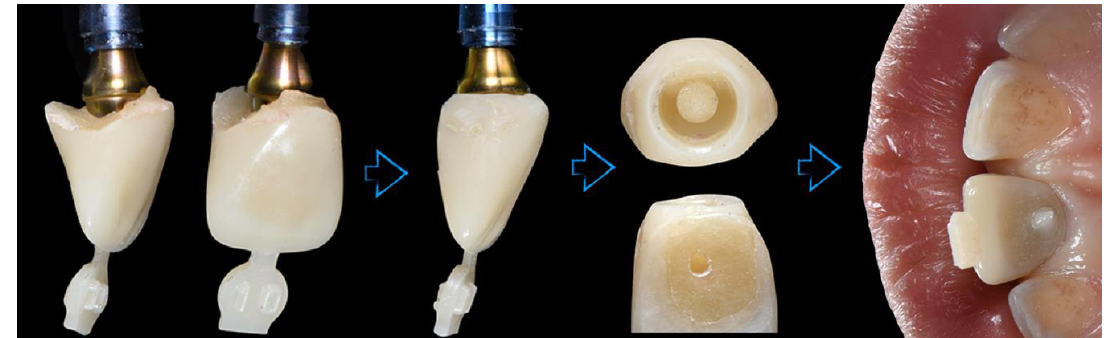
Figure 15. Fabrication and relining of the second provisional (transitional) restoration in order to guide the maturation of the per implant soft tissue to the desired architecture.